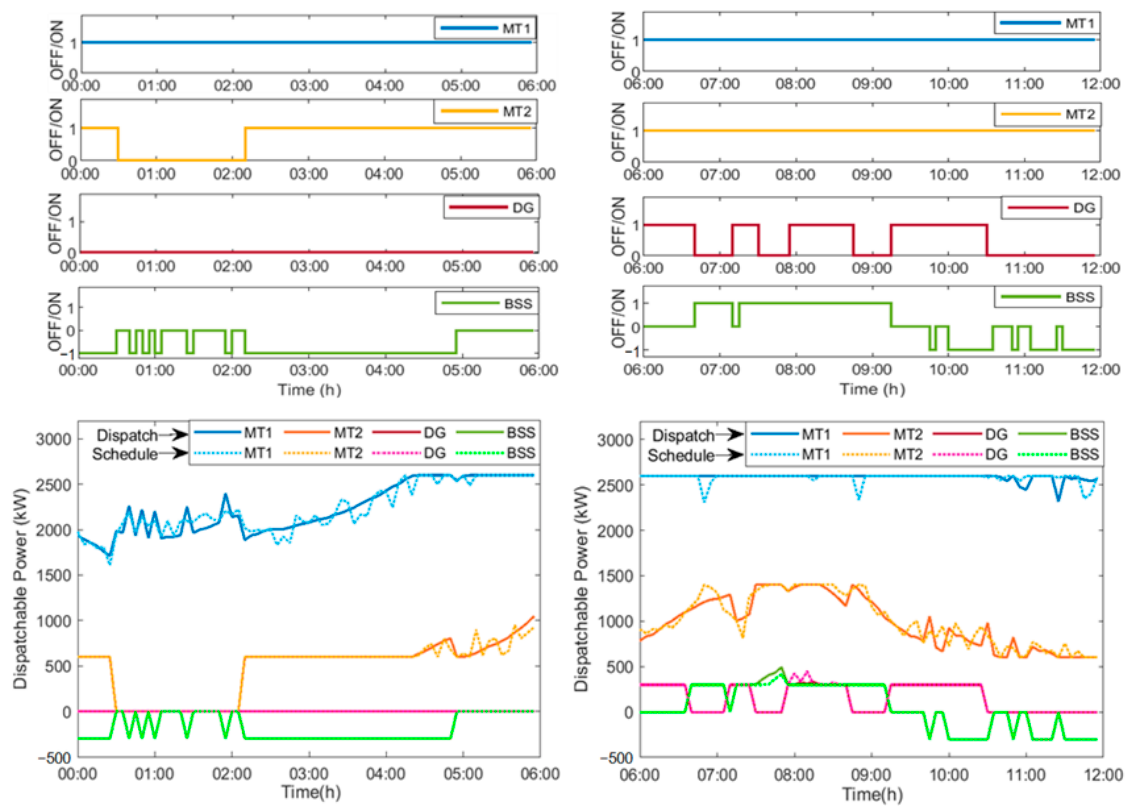
Figure 5. Simulation outcome for 34-bus system from Quarters ‘1’ (Q1, left ) and ‘2’ (Q2, right ): ( top ) control states of DER units; ( bottom ) dispatched power of DER units.